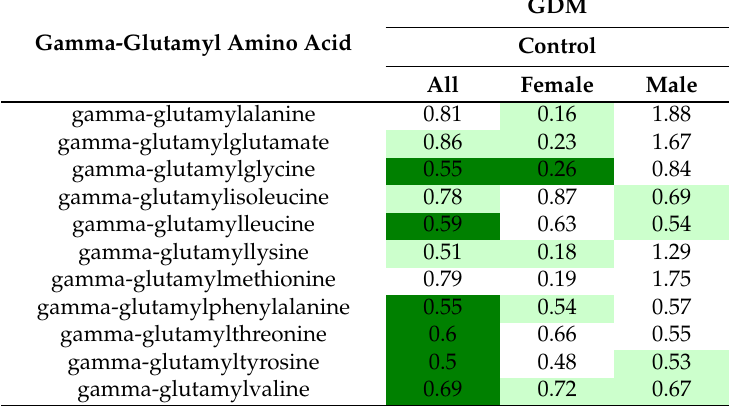
Table 4. Decreased gamma-glutamyl amino acids in amniotic fluid of women with GDM. GDM Gamma-Glutamyl Amino Acid Control All Female Male gamma-glutamylalanine 0.81 0.16 1.88 gamma-glutamylglutamate 0.86 0.23 1.67 gamma-glutamylglycine 0.55